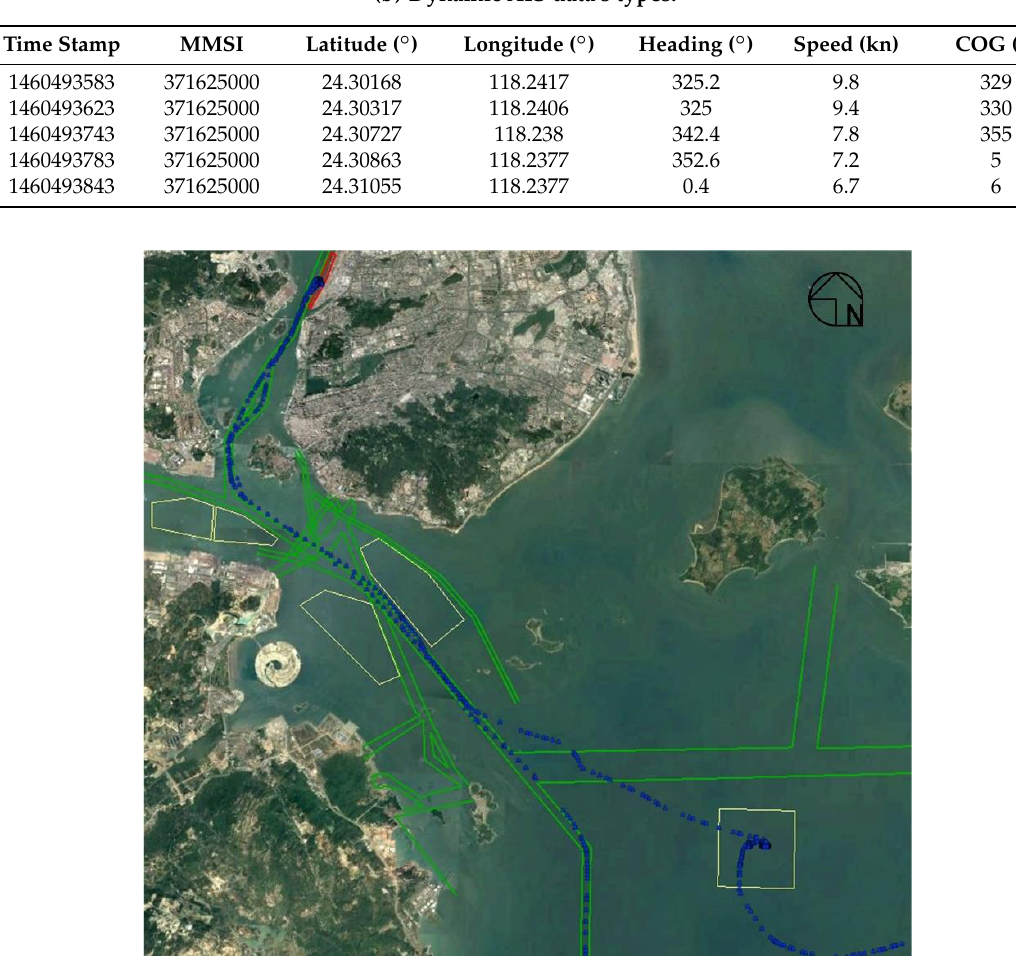
Table 2. Marginal probability of DBN.